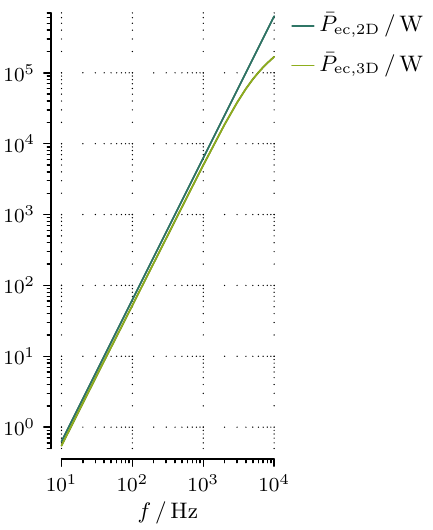
Figure 9. A comparison of ¯ P ec,2D and ¯ P ec,3D in the frequency range from 10Hz to 10kHz in the worst of the three analyzed cases regarding ε 2D in which l sl is